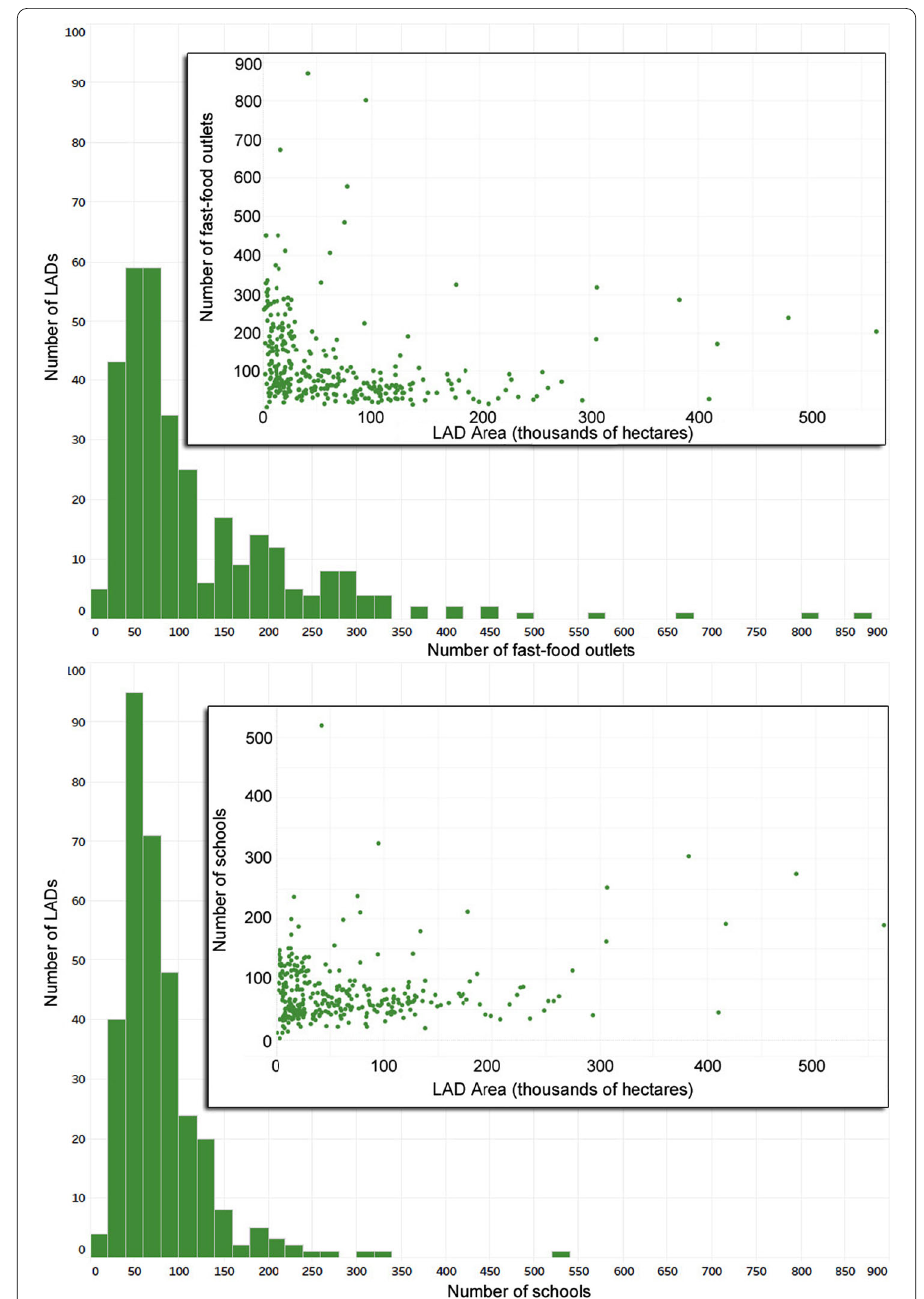
Figure 6 Distribution of the number of fast-food outlets and schools ( x -axis) across LADs ( y -axis)